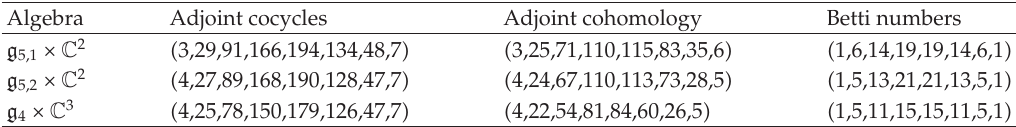
Table 8: Cohomology table for NLAs of dimension 7: rank 5.